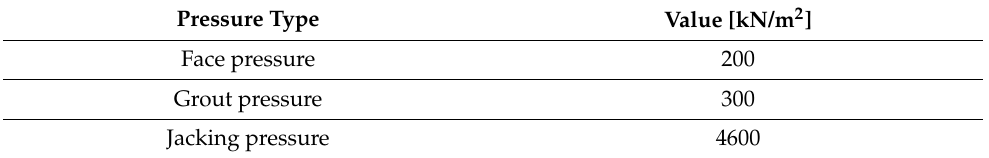
Figure 12. Construction loads. Table 5. Construction loads.